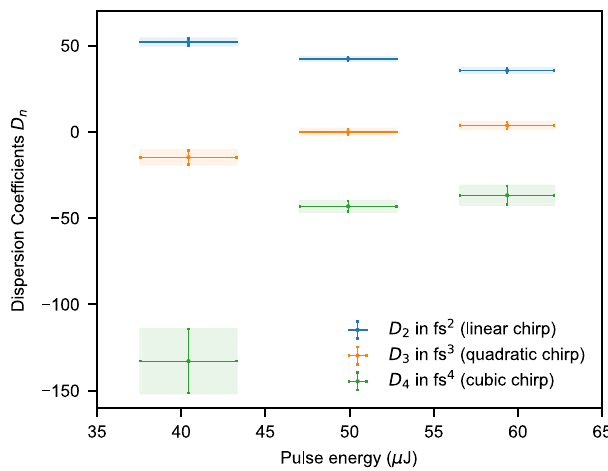
Fig. 4 Frequency-chirp characterization, analysis of dependence on the FEL pulse energy. Measured dispersion coef fi cients (blue dots: quadratic order; orange dots: cubic order; green dots: quartic order) for different FEL- pulse energy ranges between 35 and 45 µ J, 45 and 55 µ J, and 55 and 65 µ J, respectively. Given values of pulse energy represent the mean over ~5000 FEL shots, respectively, and quoted errors are standard deviations. Errors of dispersion coef fi cients specify best polynomial fi t errors accounting for the errors due to error-function curve fi tting to measured time-delay data. It should be noted that the stated numerical values for the different orders of chirp, in units of fs 2 , fs 3 , and fs 4 , are displayed on the same scale on the vertical axis, which does not re fl ect their relative contribution to the total nonlinear chirp (see “ Supplementary Note 2, Order-of-magnitude estimation of nonlinear chirp contributions ” ).